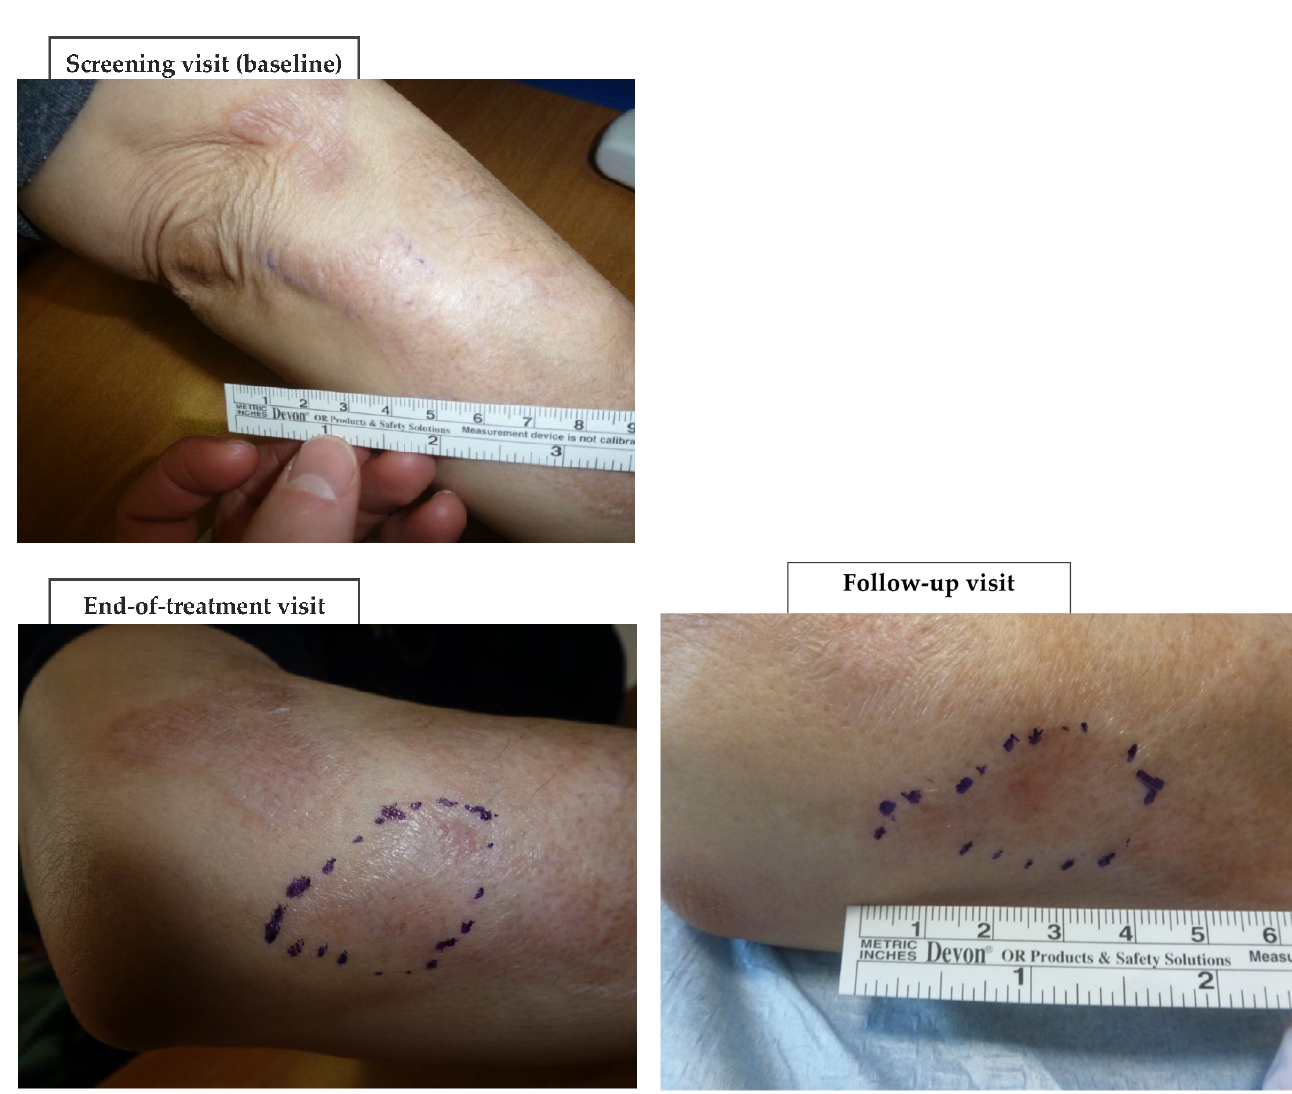
Figure 5. Mean Dermatology Life Quality Index (DLQI) score changes ± standard deviation after 90 (end ‐ of ‐ treatment visit) and 180 days (follow ‐ up visit) vs. baseline (screening visit). ** p = 0.0002 vs. screening visit.